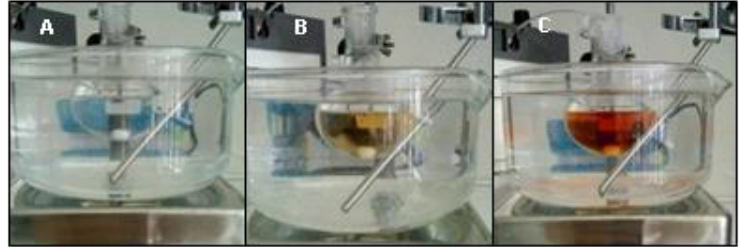
Figure 7. Biotransformation reaction: Development of the reaction using guaiacol catalyzed by the extract. ( A ) At 0 min; ( B ) at 5 min; ( C ) 10 min.